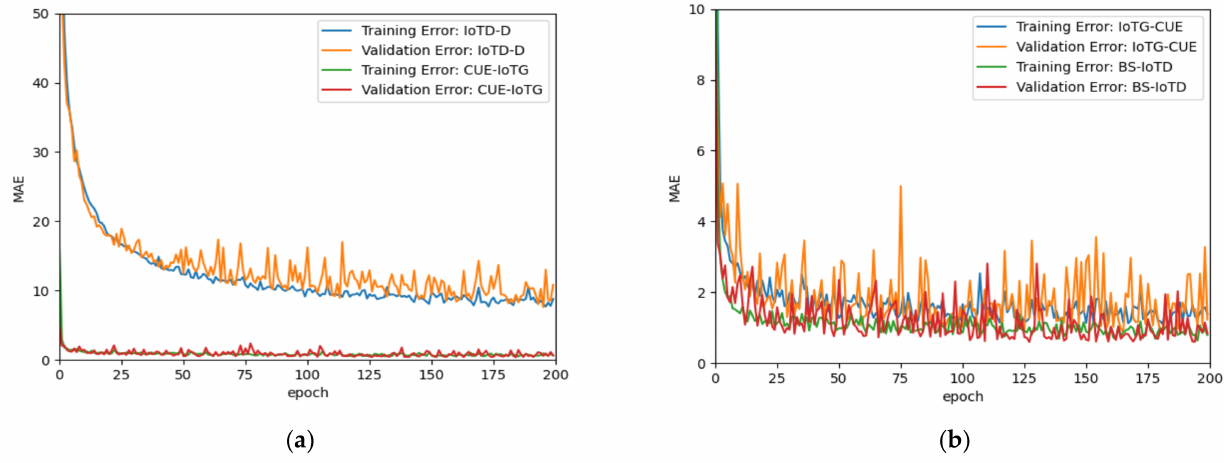
Figure 4. Mean absolute error generated by the training and validation data when calculating the output distances O-Dist1 and O-Dist2 for: ( a ) uplink communication dataset and ( b ) downlink communication